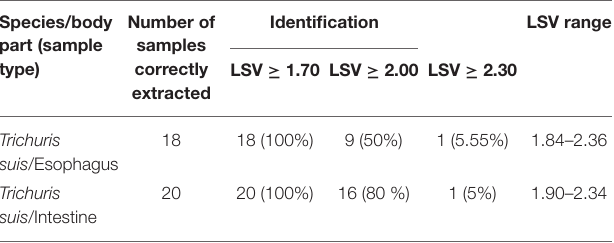
TABLE 1 | Identification of 38 T. suis samples by MALDI-TOF MS, using a preliminary developed internal database. Species/body part